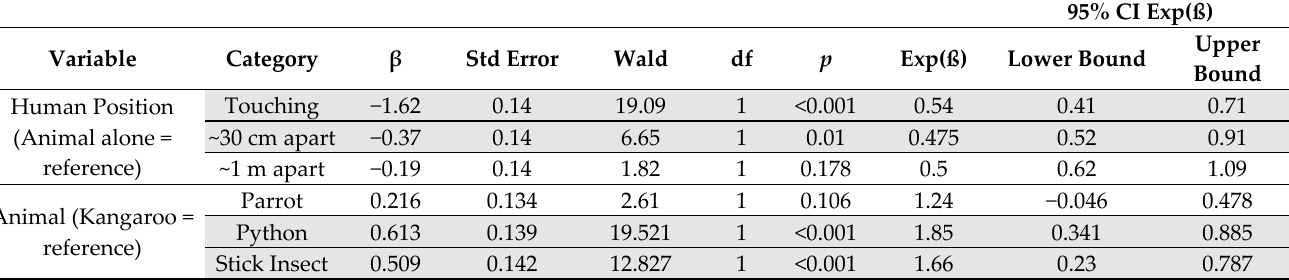
Table 4. Test statistics and effect sizes for variables in the final model to assess respondents’ agreement with the statement “the featured animal is displaying a natural behaviour”. Parameter estimate ( β ), standard error (SE), Wald statistics (Wald), degrees of freedom (df), level of significance ( p ), cumulative odds ratio (Exp ( β )), and 95% confidence interval of the cumulative odds ratio (95% CI Exp ( β )) for variables in the model. The answer options disagree, slightly disagree, neither agree nor disagree, slightly agree, and agree were coded as 1, 2, 3, 4, 5.